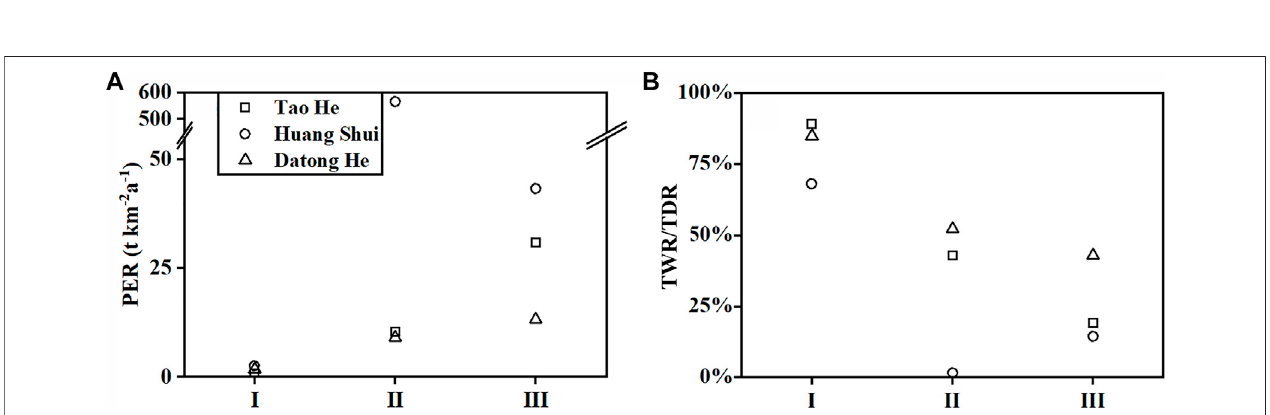
FIGURE 6 | Physical denudation rate (PER) (A) and the ratio of total chemical weathering rate (TWR) to total denudation rate (TDR) (TDR (cid:2) TWR + PER) (B) of Tao He, Huang Shui, and Datong He. I represents the QTP section, II represents the transition zones, and III represents LP section, and data are shown in Supplementary Table S6